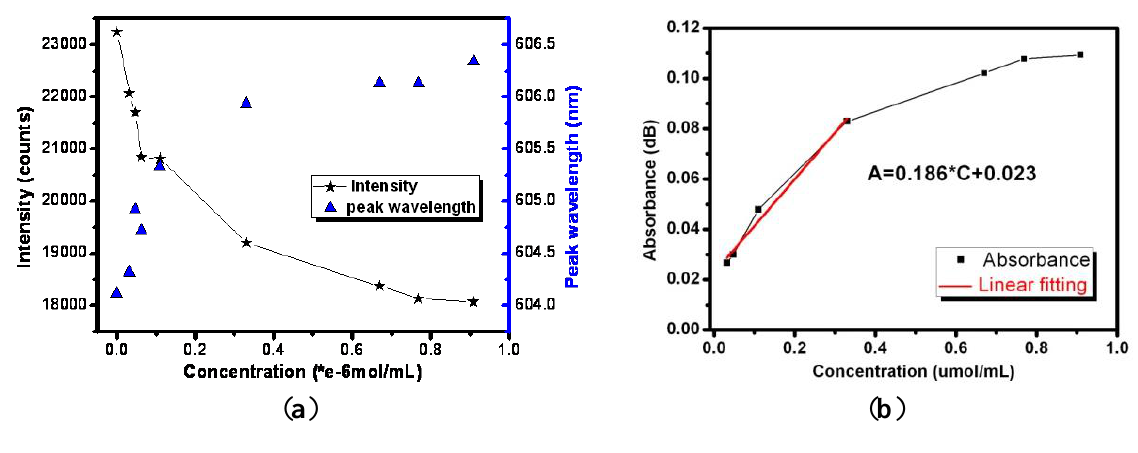
different concentrations of the analytes; ( b ) The plot of absorbance versus